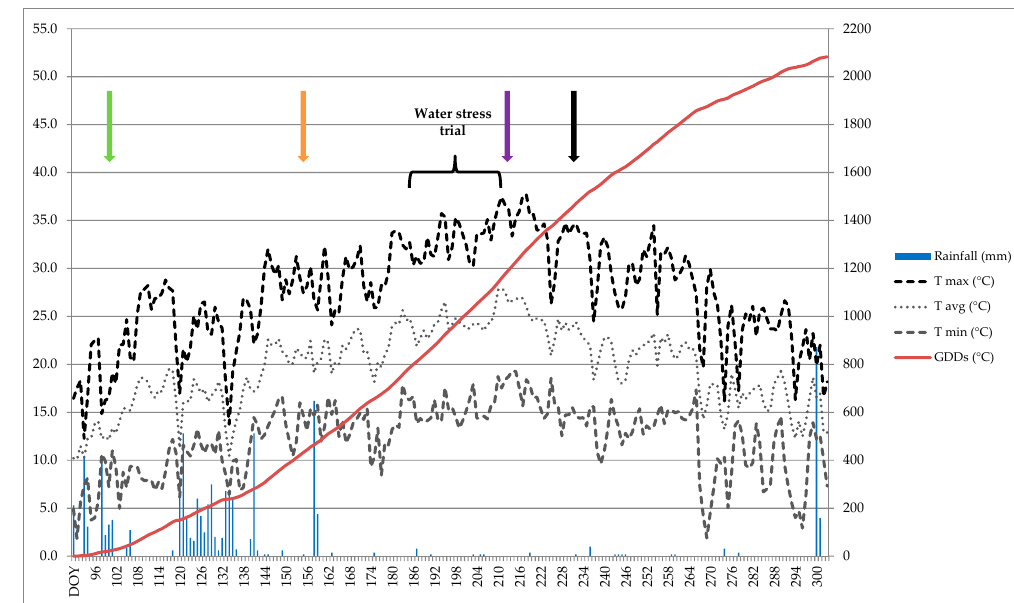
Figure 1. Weather conditions (April 1st—October 31st) of the 2018 vegetative season. Rainfall, daily rainfall (mm); T max, daily maximum temperature (°C); T avg, daily average temperature (°C); T min, daily minimum temperature (°C); GDDs, growing degree days (base 10 °C); DOY, day of year. The green arrow indicates the date of bud burst (DOY 100), the orange arrow indicates the date of flowering (DOY 155), the purple arrow indicates the date of full veraison (DOY 211), and the black arrow indicates the date of harvest (DOY 232). The black brace indicates the period of water stress trial (July 4th (DOY 185) to July 29th (DOY 210)).